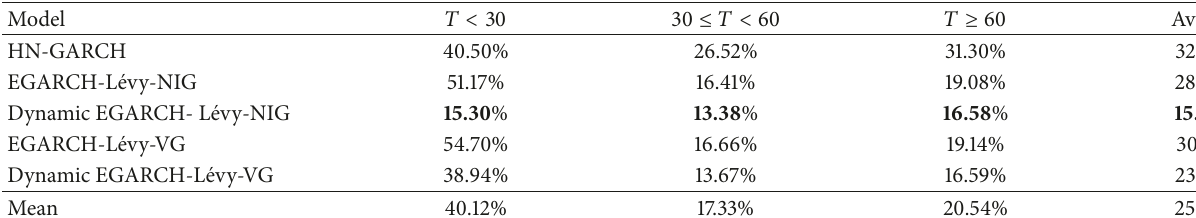
Table 2: The error of different option pricing models.